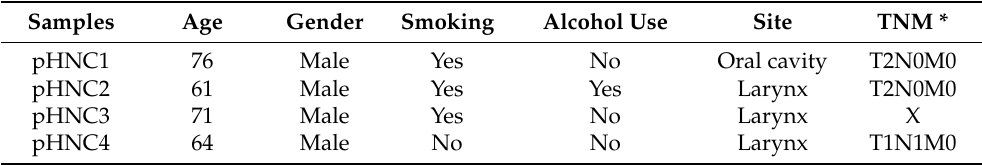
Table 1. Clinicopathological characteristics and tumor staging of samples from patients with HNSCC.